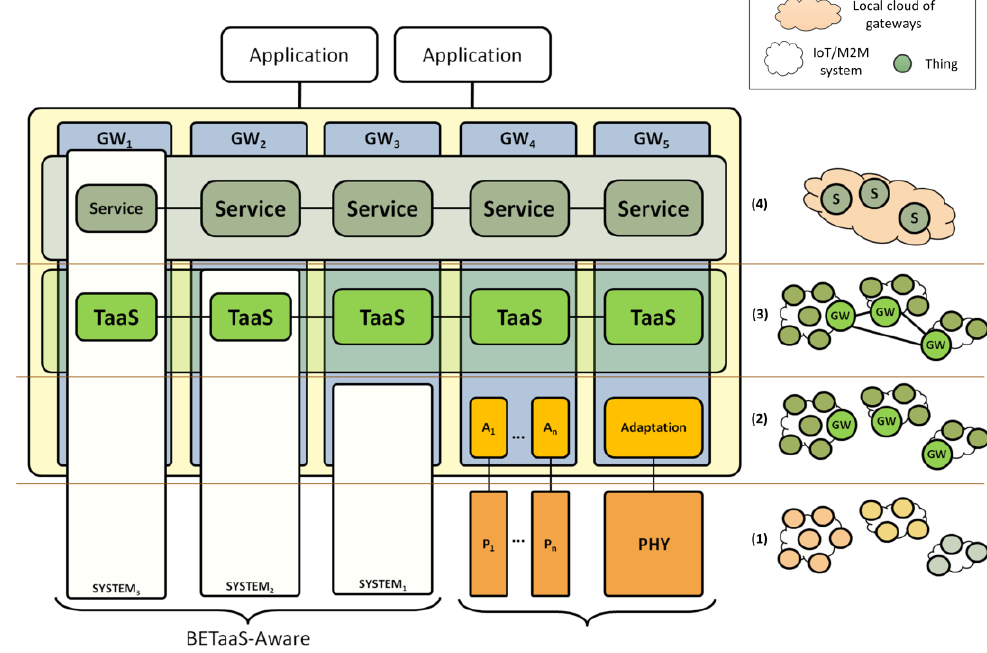
Figure 1. BETaaS concept and high level